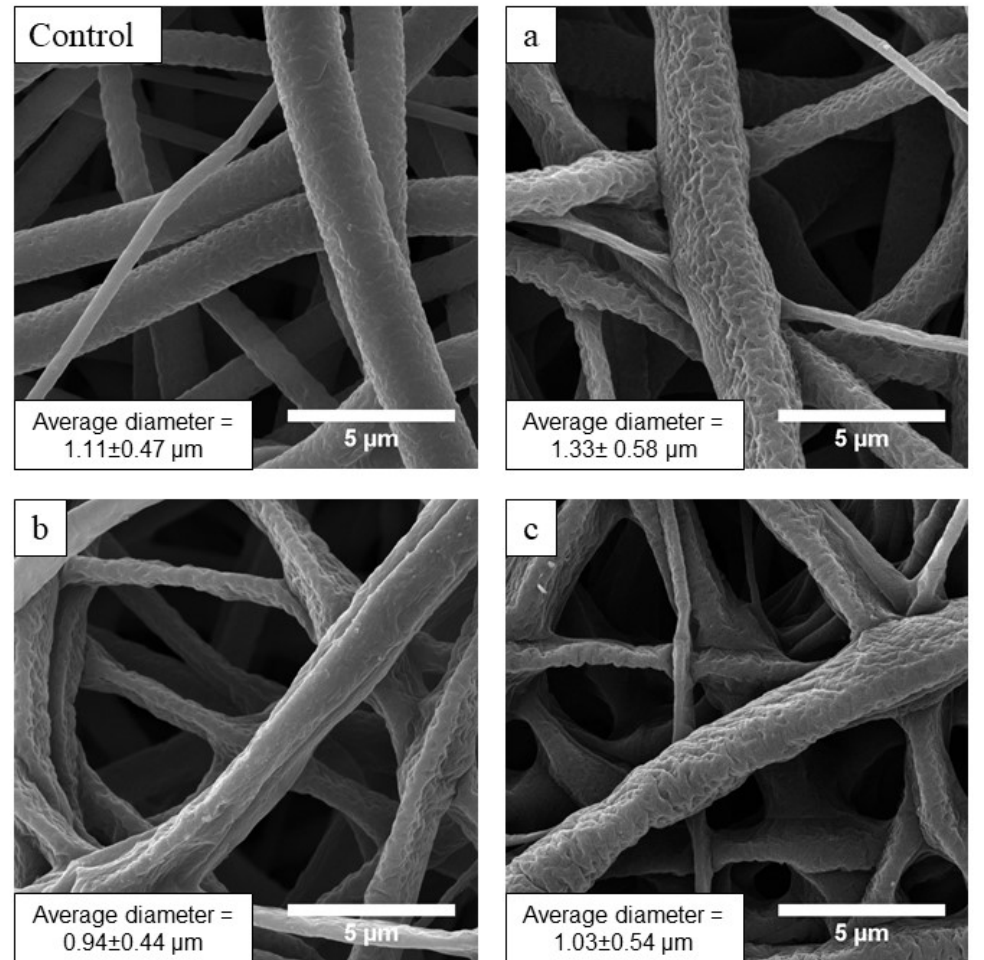
Figure 2. SEM images and average diameters of fabricated scaffolds fibers ( × 15,000 magnification) . Control —image of the control sample, ( a – c )—images of the samples coated under 5 × 10 − 3 , 5 × 10 − 2 and 5 × 10 − 1 Pa nitrogen pressure, respectively.